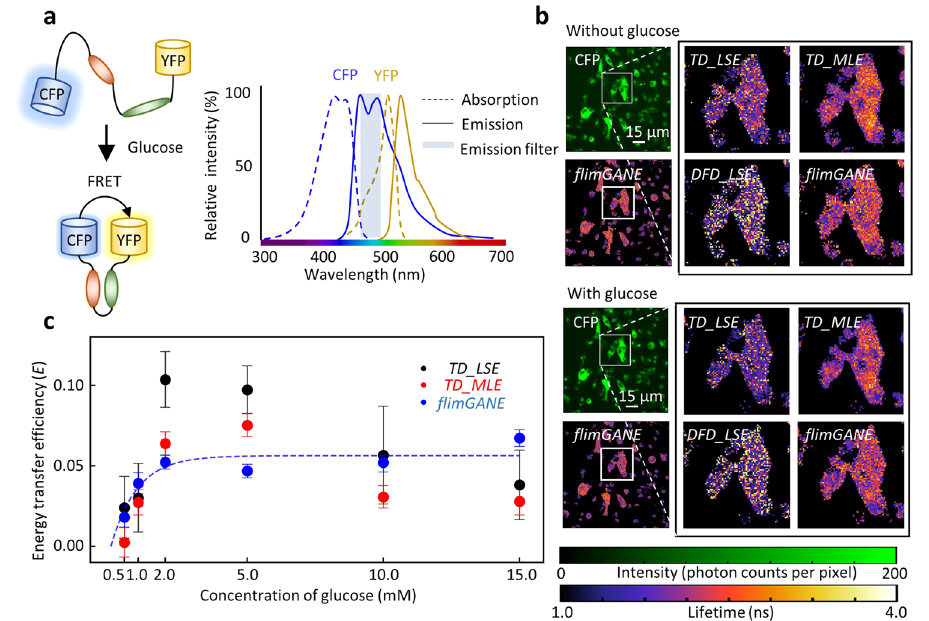
Fig. 4 fl imGANE enables accurate FRET characterization from low-photon-count data. a Schematic of CFP-g-YFP FRET pair interacting with glucose and normalized excitation and emission spectra of CFP and YFP. b Intensity contrast and FLIM images of CFP generated by TD_LSE , TD_MLE , DFD_LSE and fl imGANE before and after adding 2 mM glucose. c Energy transfer ef fi ciency, E , versus glucose concentration (error bars, standard deviation errors on the parameter estimate, n = 1507~6824 pixels). The fl imGANE FRET data can be well fi tted by a sigmoidal curve (R2 =